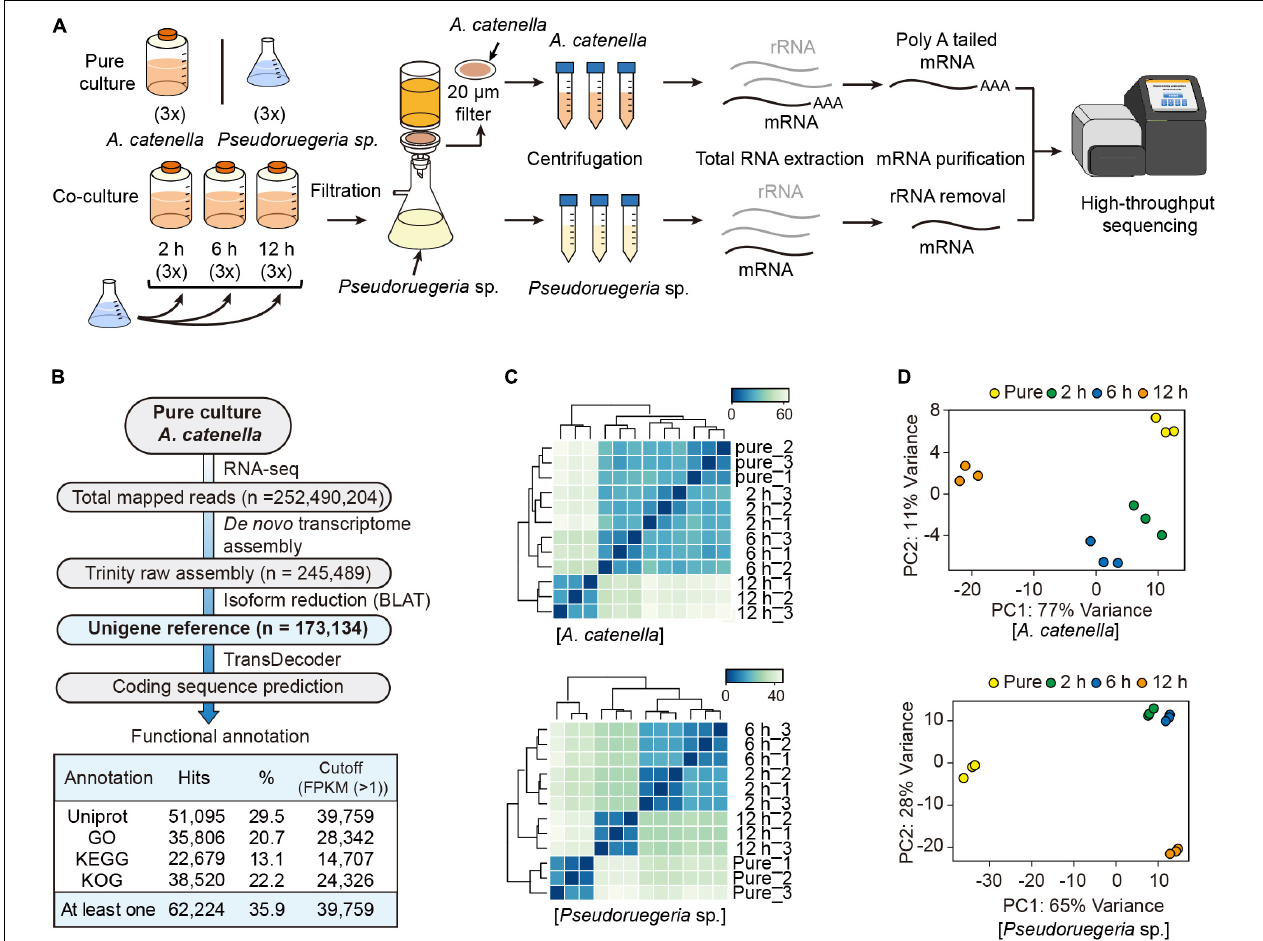
FIGURE 2 | Transcriptome analysis of A. catenella and Pseudoruegeria sp. (A) Scheme of the transcriptome analysis process. A. catenella and Pseudoruegeria sp. were each pure- cultured as the control. For the co-culture of the two organisms, 1 L of A. catenella (2,000 cells · mL − 1 ) and 100 mL of Pseudoruegeria sp. (OD 600 nm 0.3) were cultured together for 2, 6, and 12 h with light exposure. All cultures had three experimental replicates. After co-culture, the two organisms were again isolated using filtration and then collected separately for RNA extraction. Finally, the purified mRNA was sequenced using RNA-seq. (B) Pipeline for